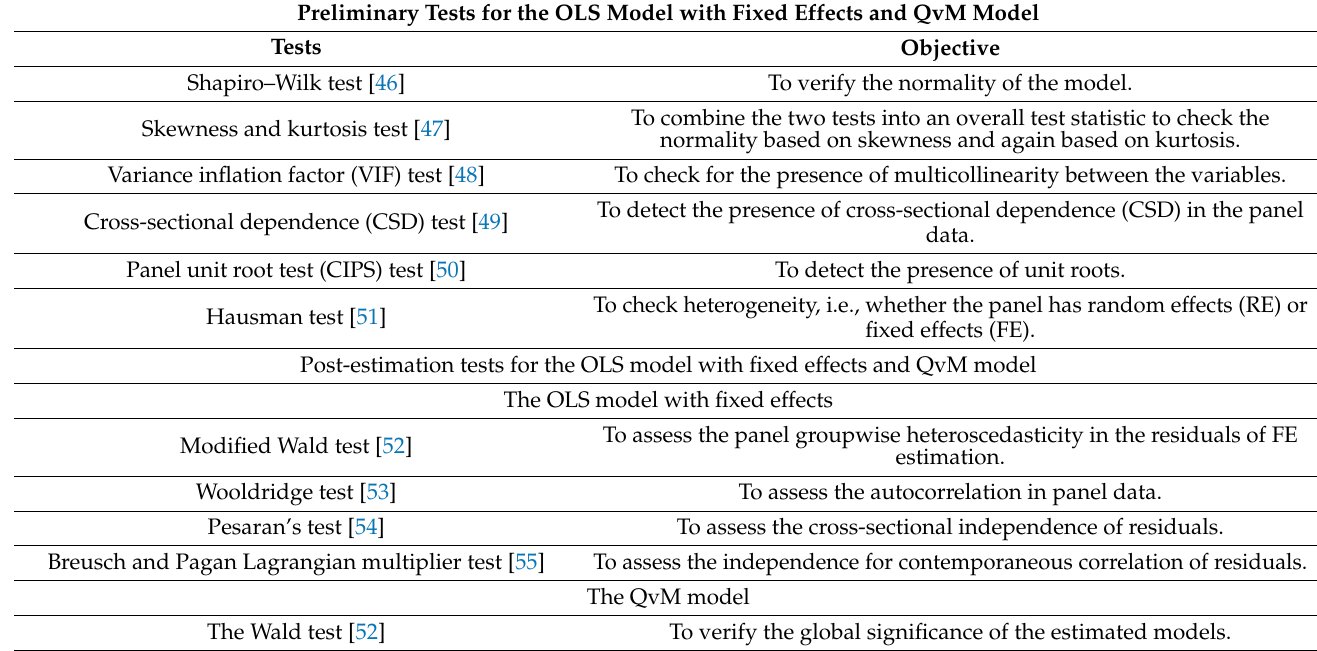
Table 2. Preliminary and post-estimation tests for the OLS model with fixed effects and QvM model.